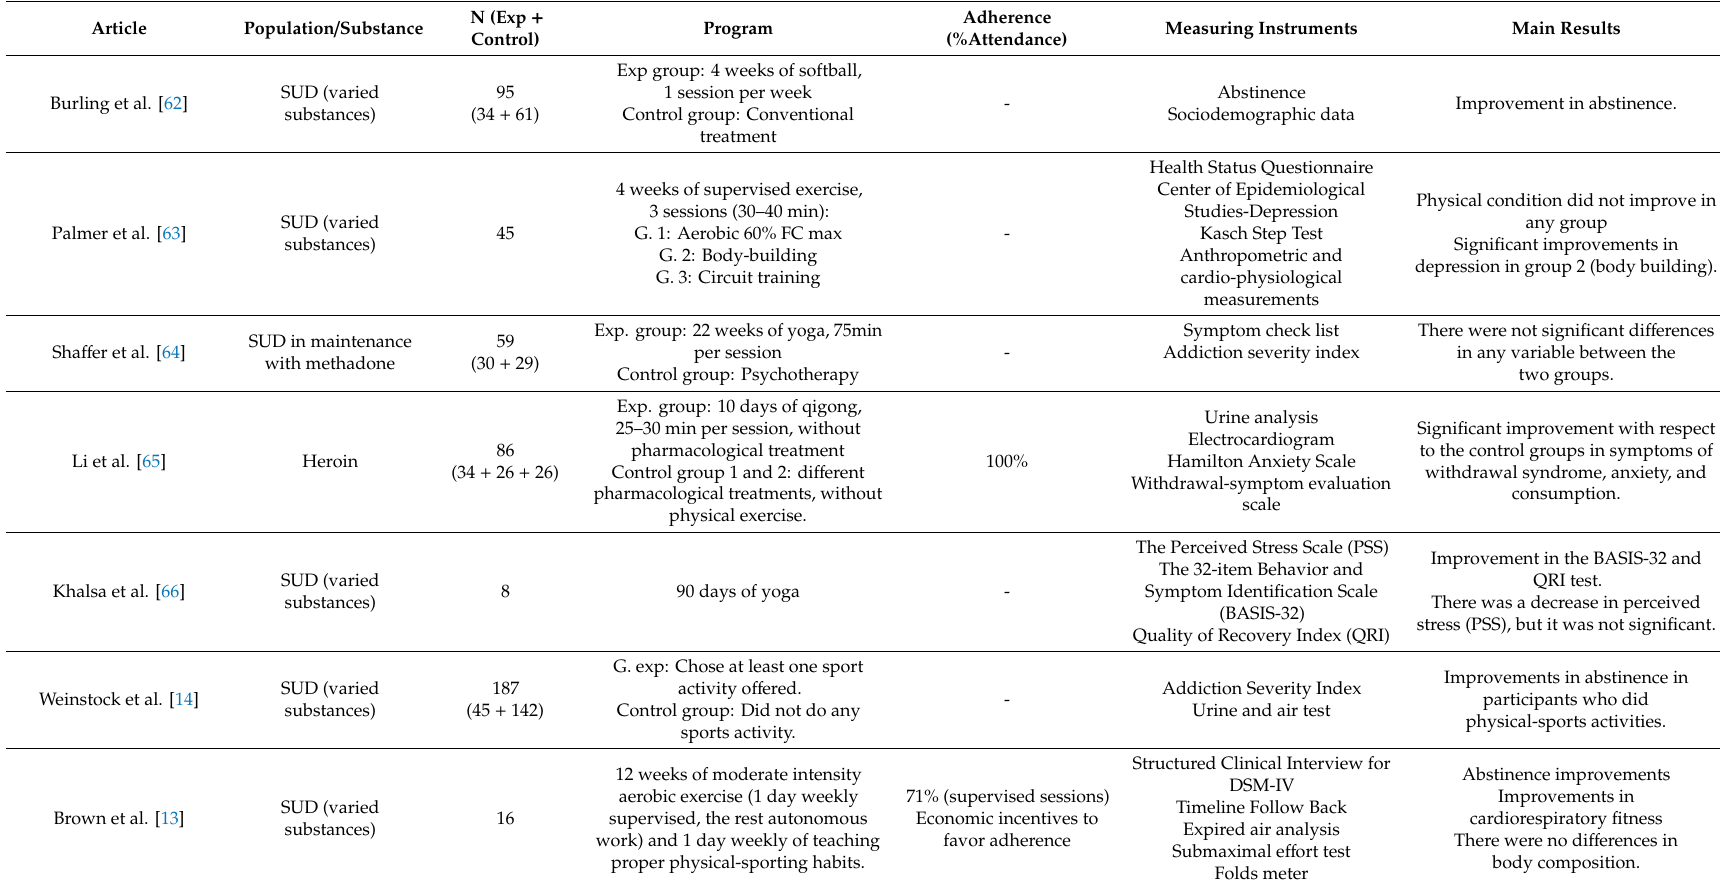
Table 4. Studies that measure the e ff ect of long-term exercise on substance use disorder (SUD)